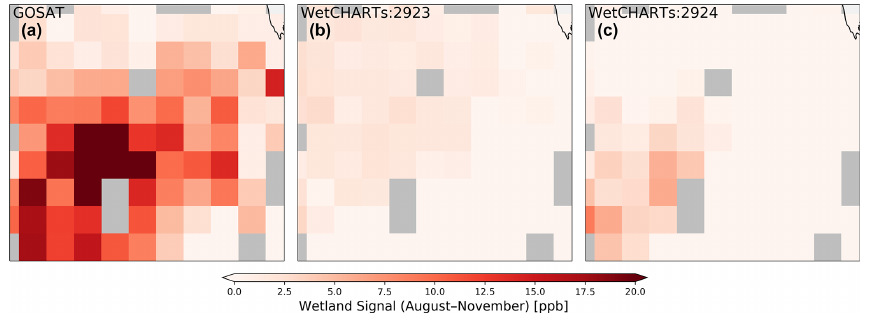
Figure 14. The average wetland signal for August–November between 2009 and 2017 over the Sudd region. The wetland signal is defined as the difference between the detrended GOSAT or WetCHARTs model simulations and the simulation with no wetland emissions. Two WetCHARTs ensemble members are shown (2923 and 2924) for illustration, but all ensemble members exhibit similar behaviour.